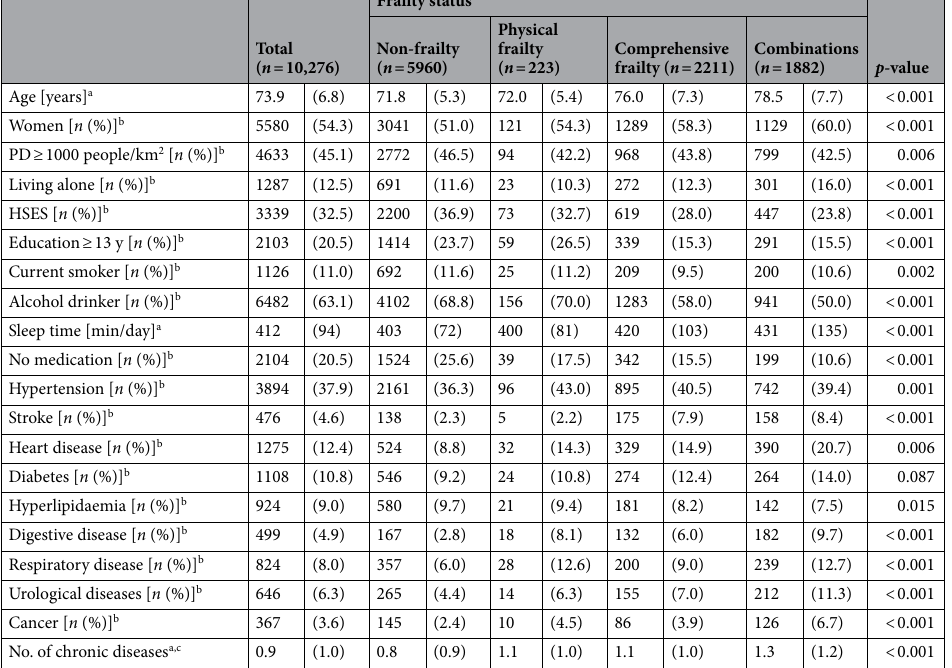
Table 1. Baseline characteristics of participants by frailty status. Data for participants with missing values were imputed by multiple imputation: family structure ( n = 675); socioeconomic status ( n = 395); education ( n = 1139); smoking status ( n = 257); alcohol status ( n = 230); sleep time ( n = 536); medications ( n = 657). HSES high socioeconomic status, PD population density. a Continuous variables were shown in terms of mean with standard deviation and were analysed using variance analysis. b Category variables were shown in terms of the number of cases with percentage and were analysed using the Pearson’s Chi-square test. c From the data obtained on disease status (including the presence of hypertension, stroke, heart disease, diabetes, hyperlipidaemia, digestive disease, respiratory disease, urological diseases, and cancer), the comorbidity scores were summed to obtain a total score ranging from 0 (no comorbidity) to 9 (poor status) 19